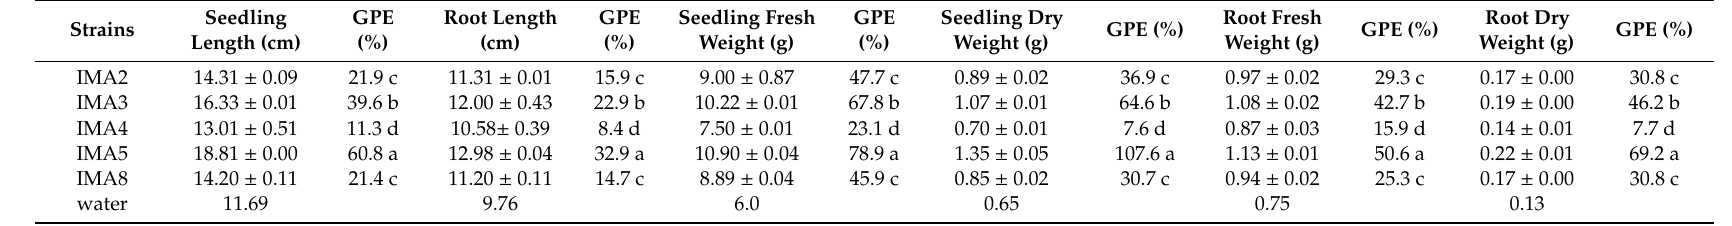
Table 5. E ff ect of five antagonistic bacterial strains on growth promotion of eggplant 40 days after